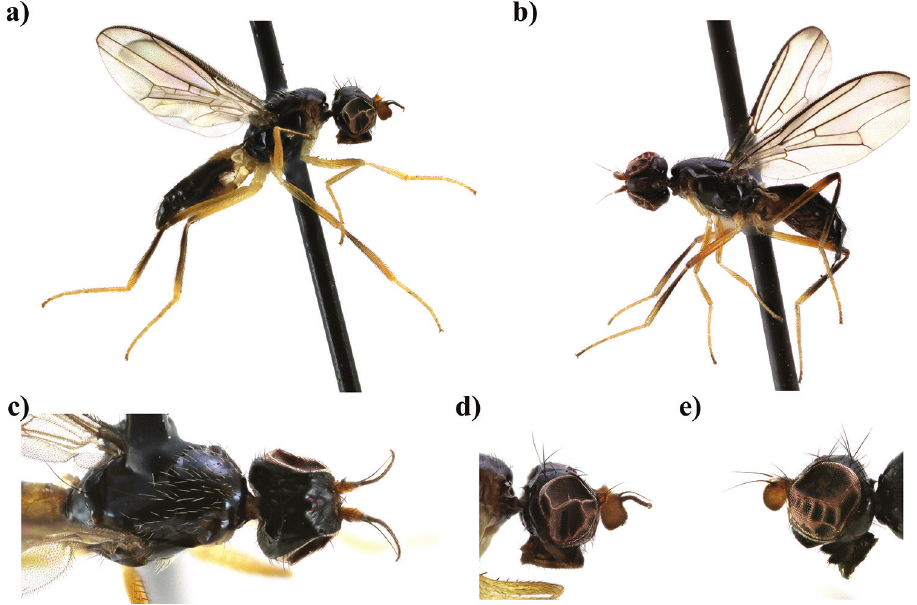
Figure 10. Strongylophthalmyia thaii L. Papp, 2006 a habitus male, lateral view b habitus female, lateral view c head and thorax, male, dorsal view; head, anterior view d head, male, lateral view e head, female, lateral